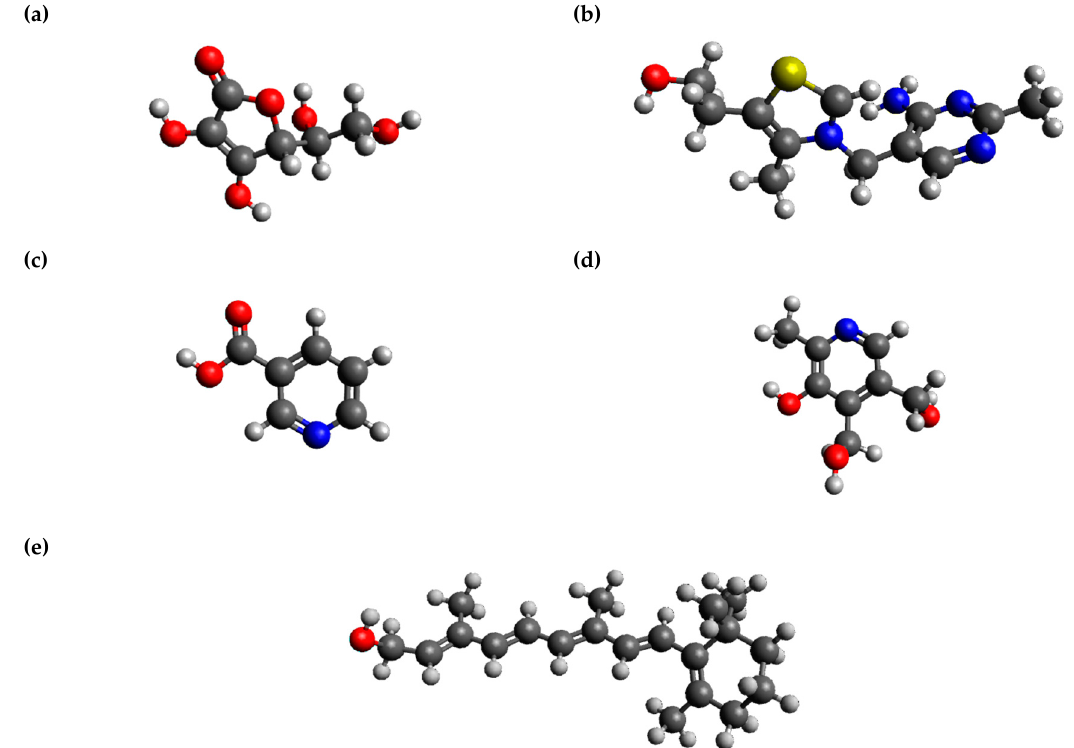
Figure 2. Geometries for ( a ) vitamin C, ( b ) vitamin B1, ( c ) vitamin B3, ( d ) vitamin B6, and ( e ) vitamin A in aqueous phase. Color atoms: for O, for C, for N, for S, for H.